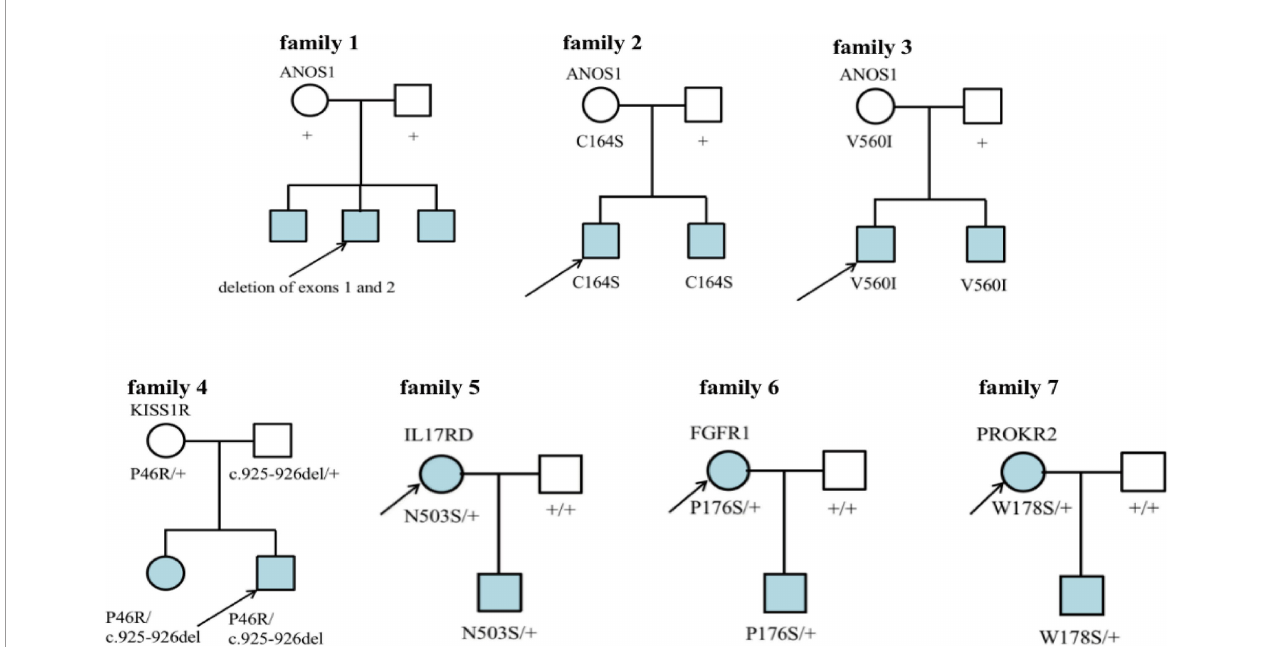
FIGURE 6 | Family map of 7 CHH patients. Families 1-3 were KS patients, all probands harbored ANOS1 mutation. Families 4-7 were nHH patients. In families 5-7, mothers of the patiens were probands and gave birth to children after treatment, which further con fi rmed that N503S of IL17RD , P176S of FGFR1 and W178S of PROKR2 had relatively little effect on reproduction and could restore reproductive function after treatment. + denotes wild-type